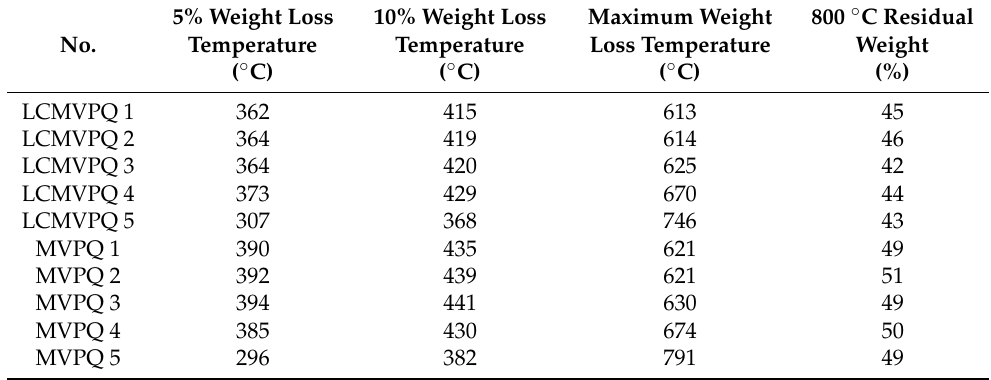
Table 4. Summary of 5%, 10%, maximum weight loss temperature and 800 ◦ C residual weight. 5% Weight Loss No. ( ◦